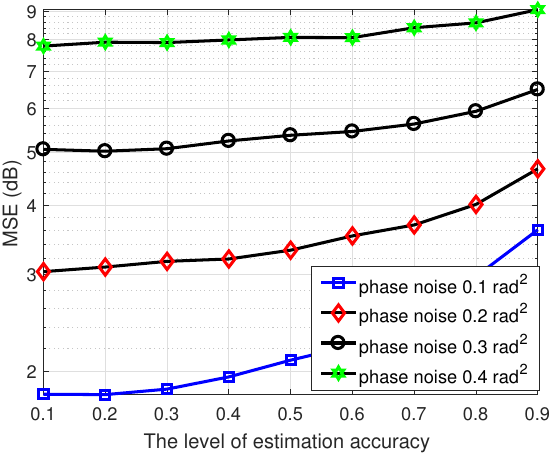
Figure 5. MSE as a function of channel estimation accuracy for the different values of phase noise variance, 4-bit